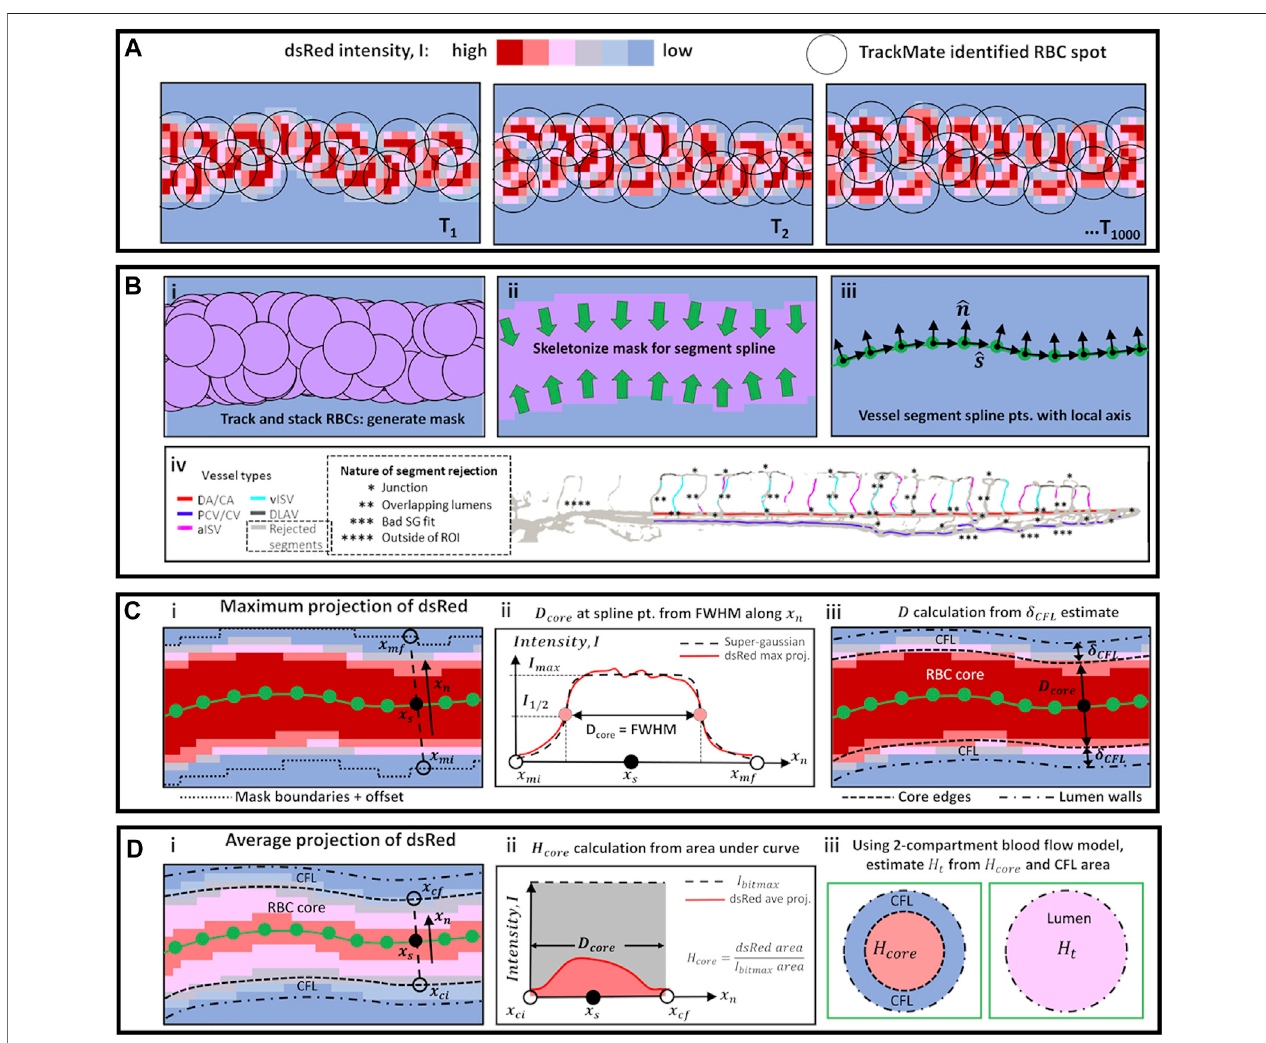
FIGURE 1 | Schematic diagrams of methods used for automated vessel labeling, data fi ltering, and vessel diameter and hematocrit calculation. (A) High speed imagesequence of dsRed intensity wasthe only collected data from experiments. (B) Series of steps using TrackMate data (i – iii) toobtain vessel spline segmentpoints and directions ^ s and ^ n , and (iv) perform script-automated vessel-type labeling and data fi ltering from the spline segment skeletons in iii (see text for explanation). (C) Sequence of steps to calculate the width of the RBC core ( D core ) at a spline location (i) by evaluating the full-width-half-maximum (FWHM) range of the Super- gaussian fi ttothemaximumprojectionsignal (ii) .Thelumendiameter D isobtainedbyiterativeevaluation(seetext)ofthecell-freeplasmalayer(CFL)thickness( δ CFL ). (D) Sequence of steps to calculate the core hematocrit ( H core ) at a spline location (i) by taking the area fraction between ceiling intensity ( I bitmax ) and the average projection signal within the RBC core width (ii) . The tube hematocrit in the lumen ( H t ) is evaluated by considering the effective contribution of RBC-rich core and plasma-rich CFL.